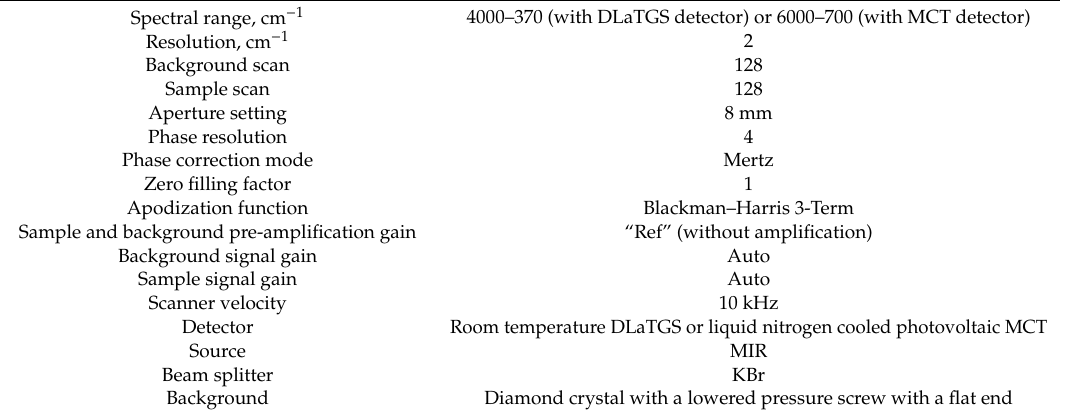
Table 3. Parameters of recording NDs spectra in the middle IR by